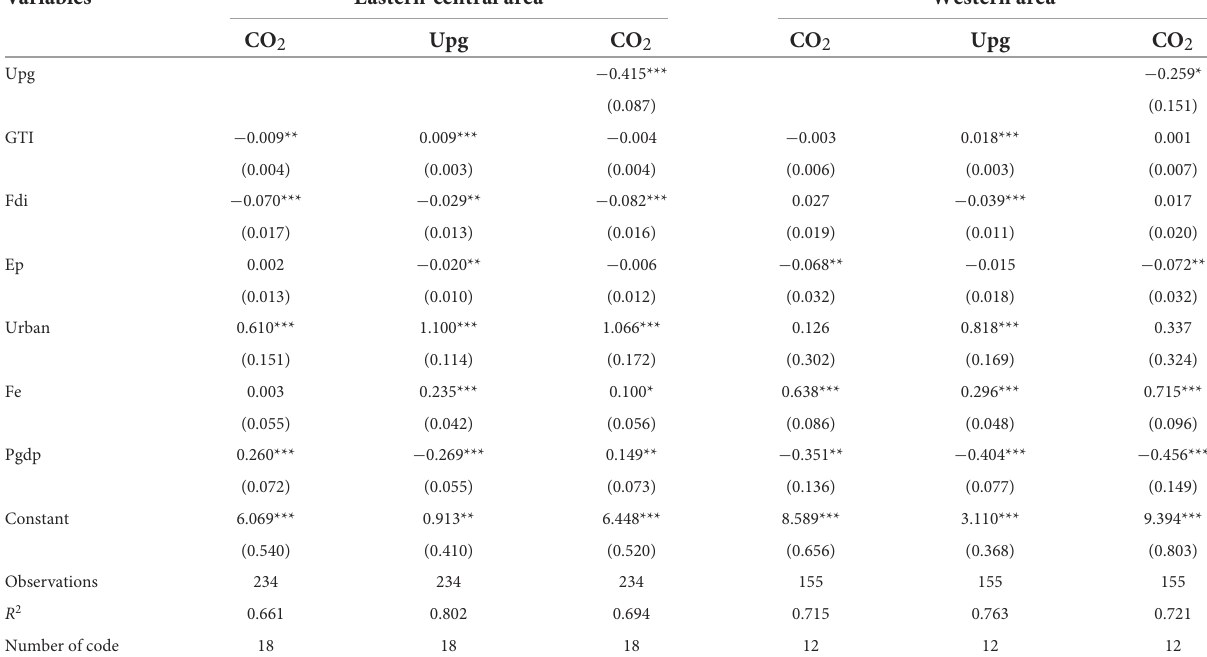
TABLE 5 Regional heterogeneity results.